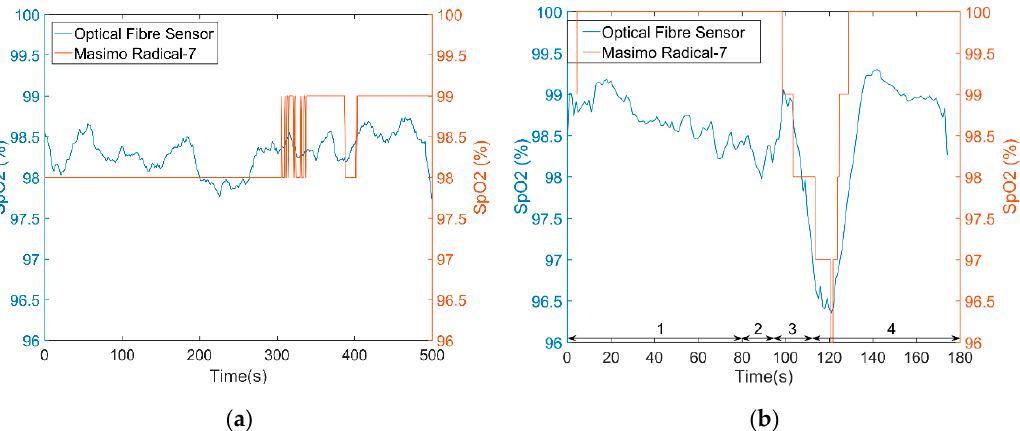
Figure 5. Comparison of optical fibre sensor with commercial pulse oximeter ( a ) During normal breathing both devices record stable values with the absolute error 0.443 ± 0.466%. ( b ) S p O 2 test result with a desaturation event. Phase 1: Breathe normally (80 s). Phase 2: Breathe out (14 s). Phase 3: Hold breath (19 s). Phase 4: Breathe normally (66 s). Both devices identify the desaturation event with the absolute error 1.16 ± 0.423% across the trace.